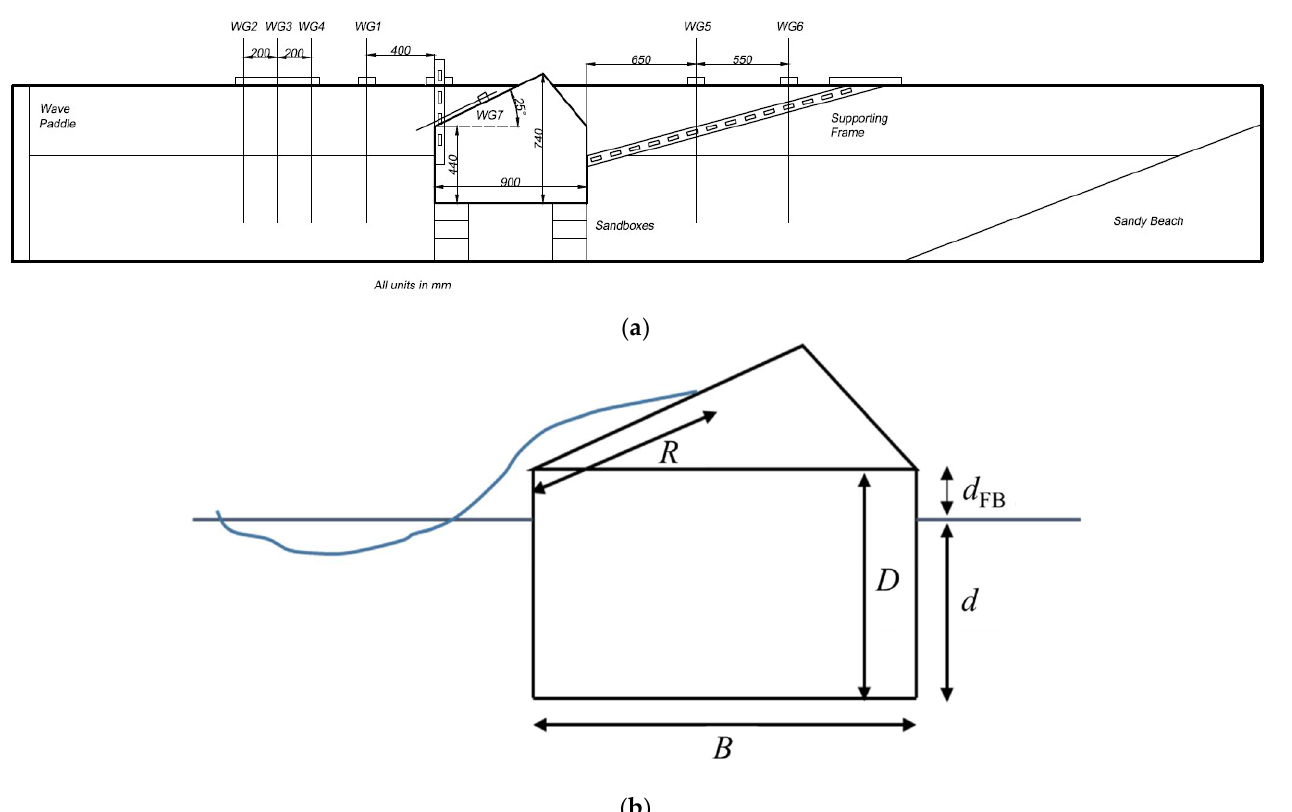
Figure 3. Model test details, ( a ) Model test setup [26], reprinted with permission from [25], 2022, Elsevier, License No.5401640097608; ( b ) Breakwater main dimensions.